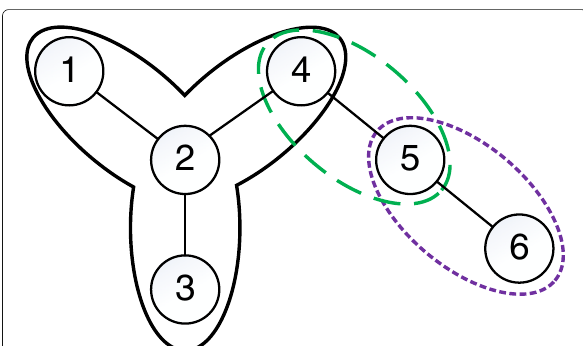
Fig. 1 An example demonstrating how hyperedges are created. Both the underlying graph (simple edges in black straight lines) and the hypergraph (hyperedges as ellipsoids) are shown for comparison